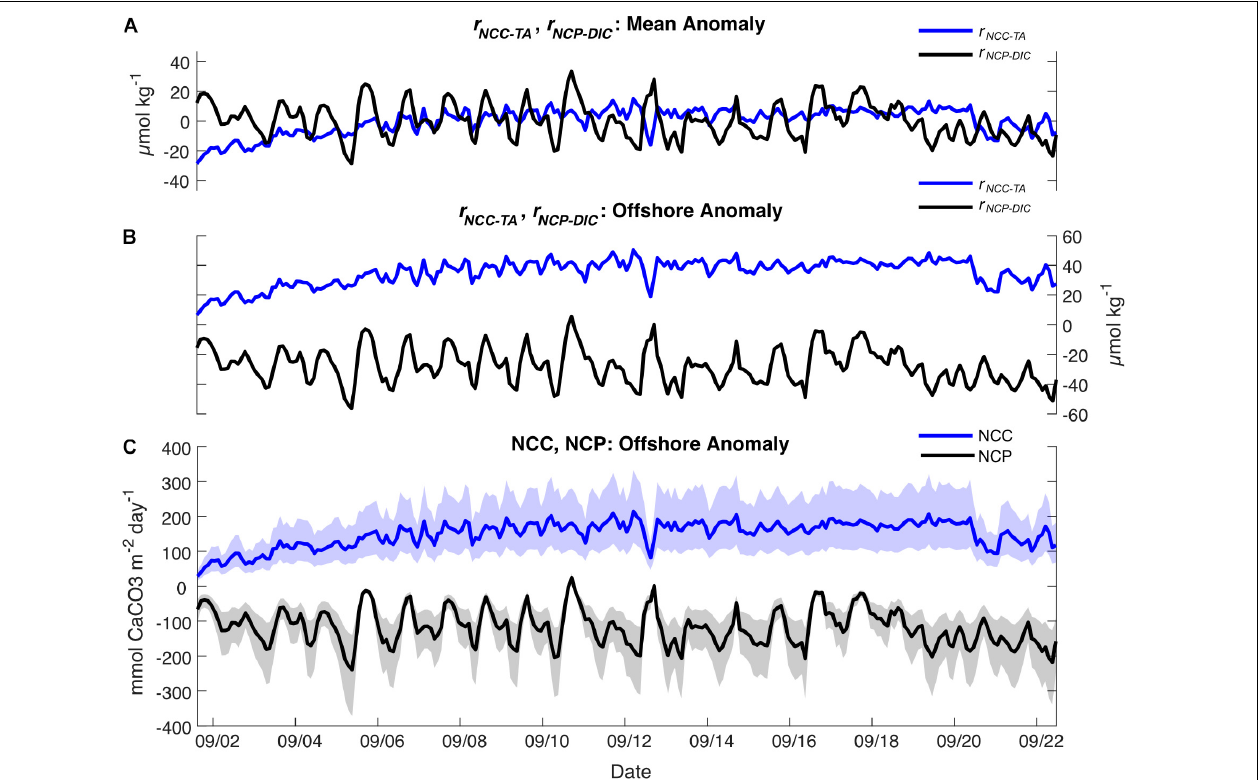
FIGURE 7 | (A) r NCC-TA (blue) and r NCP- DIC (black) calculated relative to the local means; (B) r NCC-TA (blue) and r NCP- DIC (black) calculated relative to the offshore value at the BATS Station; (C) Rates of NCC (blue) and NCP (black) (mean ± shaded uncertainty) calculated relative to the offshore value at the BATS Station.